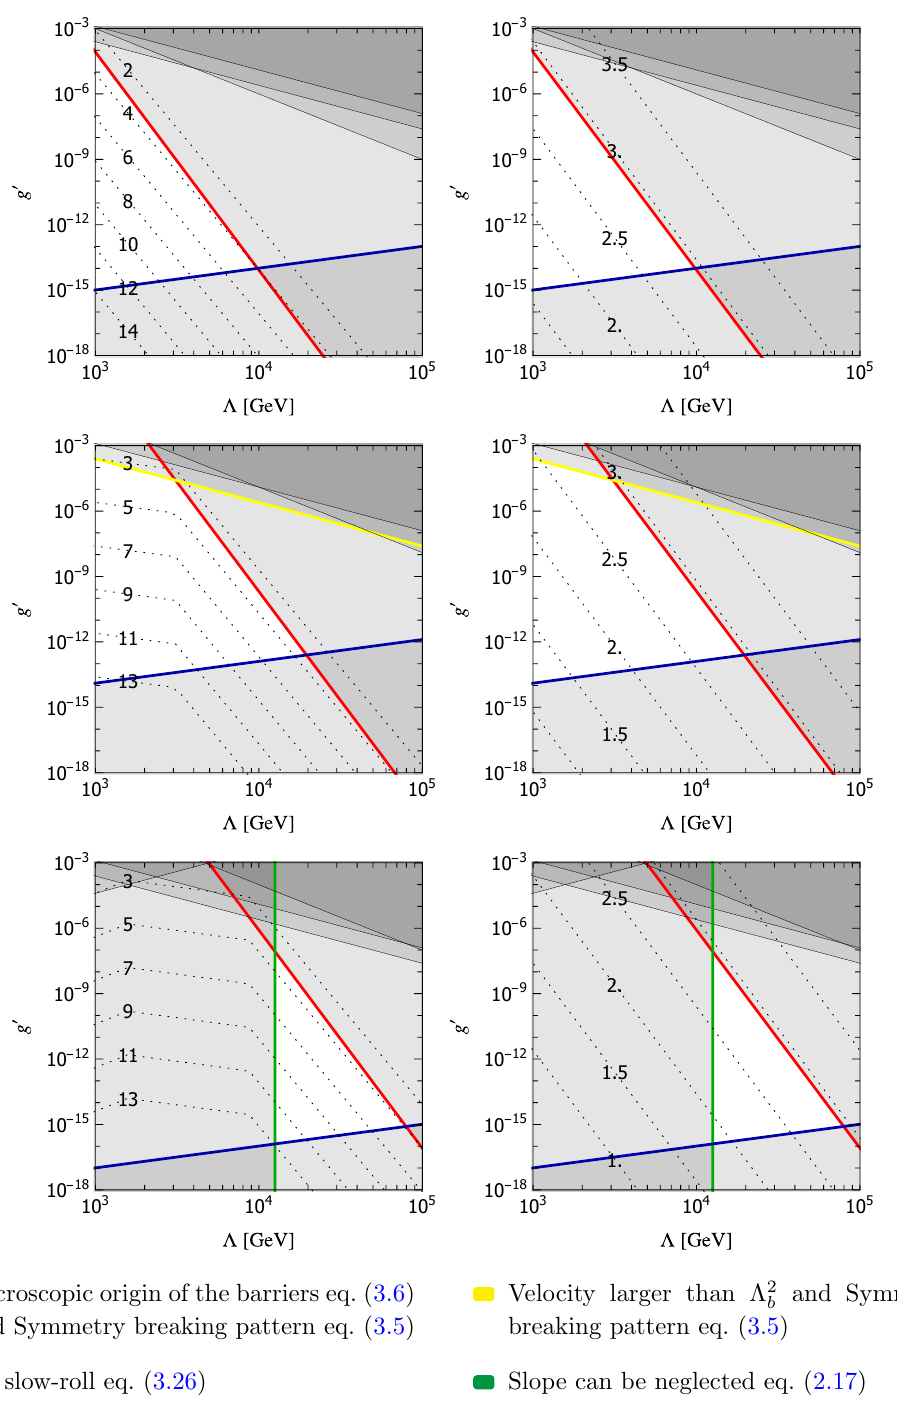
Figure 26 . Same regions as in (cid:12)gure 25 (self-stopping relaxion NOT during in(cid:13)ation) where we show the contours of log ( f max) (left) and log ((cid:3) b; min ) (right) in GeV. From top to bottom: 10 10 _ (cid:30) 0 =